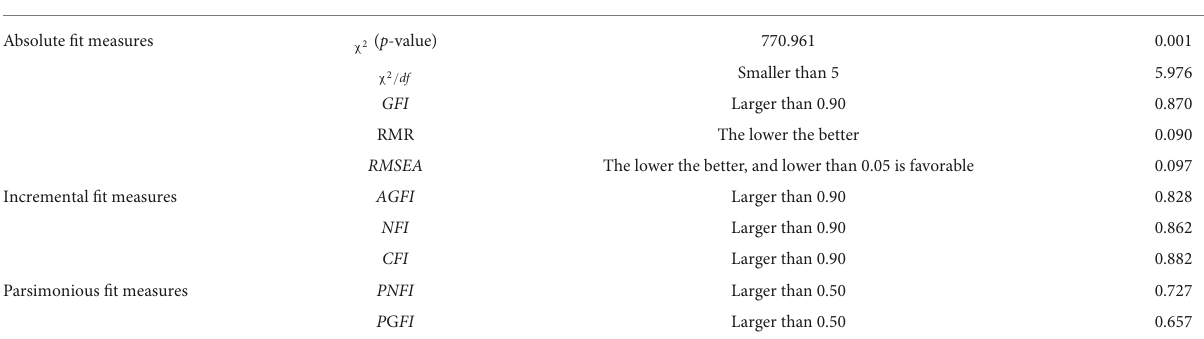
TABLE 5 Fit measures of the conceptual